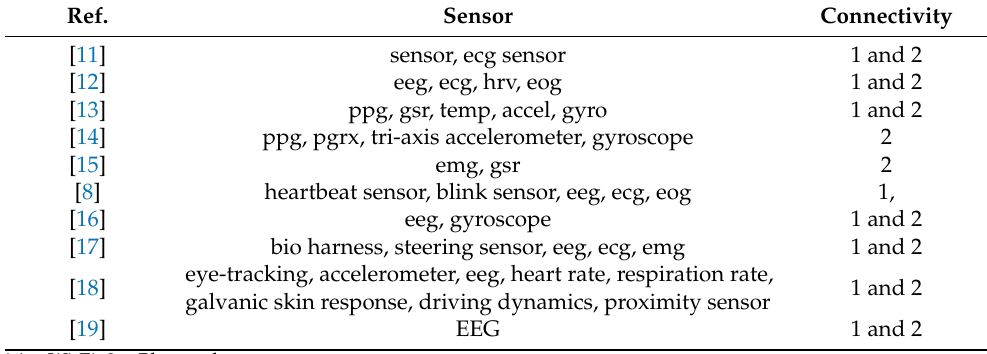
Table 1. Sensor and wearable